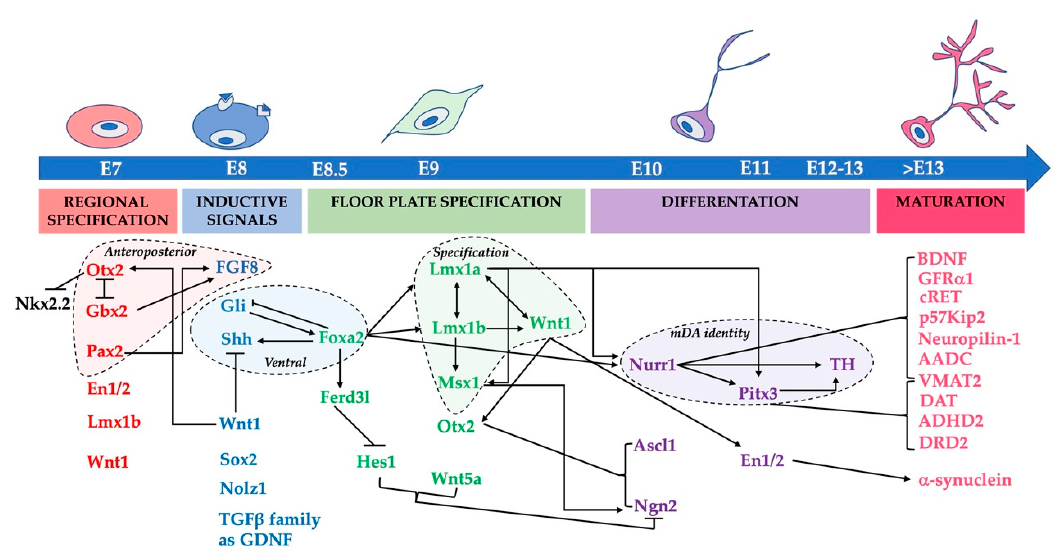
Figure 2. Genetic networks controlling midbrain dopaminergic neuron development in the mouse brain. The diagram summarizes the sequential stages and the molecules involved in mouse midbrain DA neuron embryonic development. The expression of transcription factors (TF) and secreted molecules involved in midbrain regional specification, induction, floor plate specification, di ff erentiation and maturation of the mDA phenotype are indicated, at various embryonic (E) ages. Lines depict possible interactions among these molecules. Arrows indicate stimulatory e ff ects, while perpendicular lines denote inhibitory e ff ects. The orange area, delimited by a dotted line, clusters the TFs and molecules involved in anteroposterior patterning (see text). The light blue area, delimited by a dotted line, clusters the TFs involved in ventral patterning (see text). The green area, delimited by a dotted line, groups the TFs involved in midbrain floor plate specification (see text). The violet area, delimited by a dotted line, collects the TFs involved in mDA identity (see text).